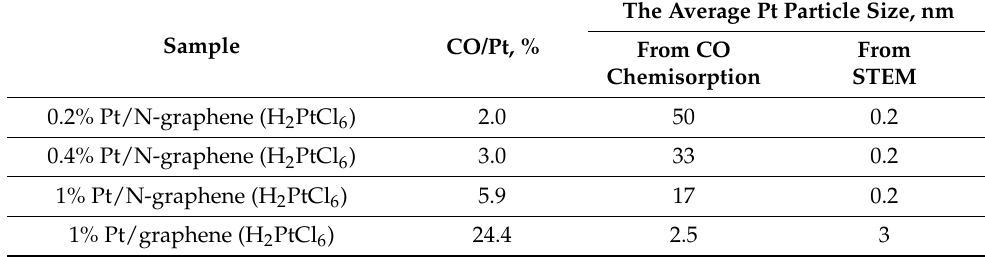
Table 2. Average sizes of platinum particles Pt/N-graphene (H 2 PtCl 6 ) catalysts determined by CO chemisorption and STEM.